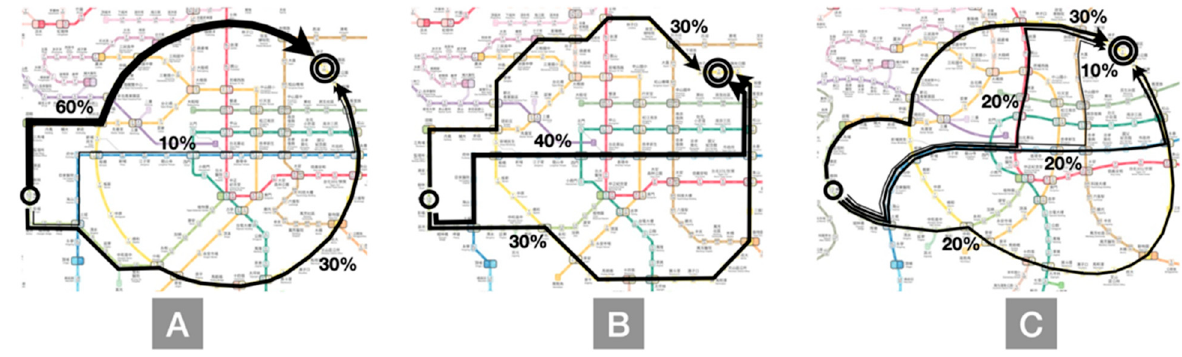
Figure 14. Proposal ( A – C ) showed fewer detours and transfers were both crucial appeals in route planning.